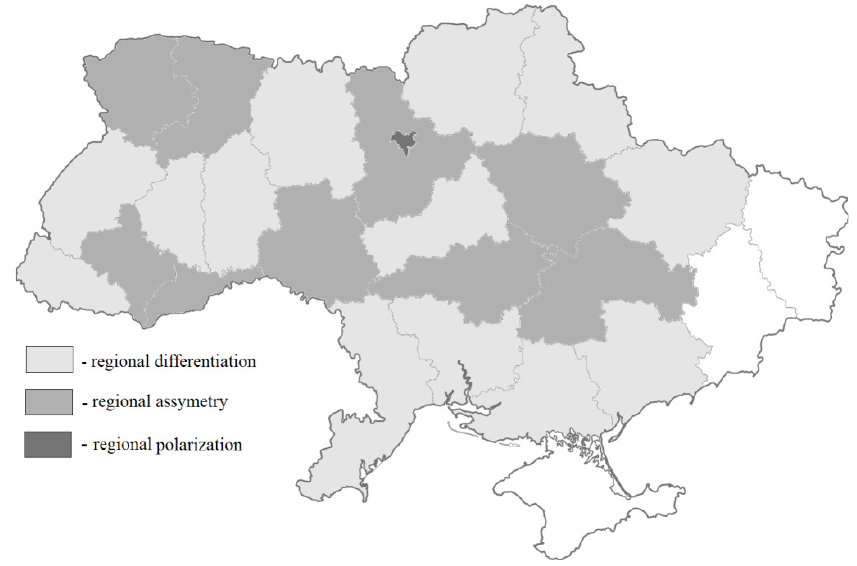
Figure 2. Regional disparities in Ukraine in